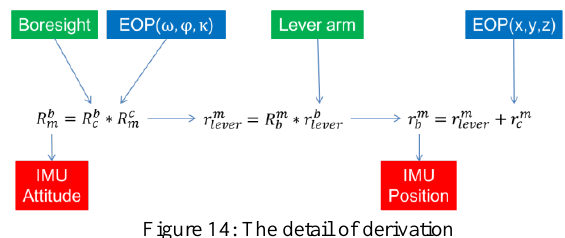
Figure 14: The detail of derivation